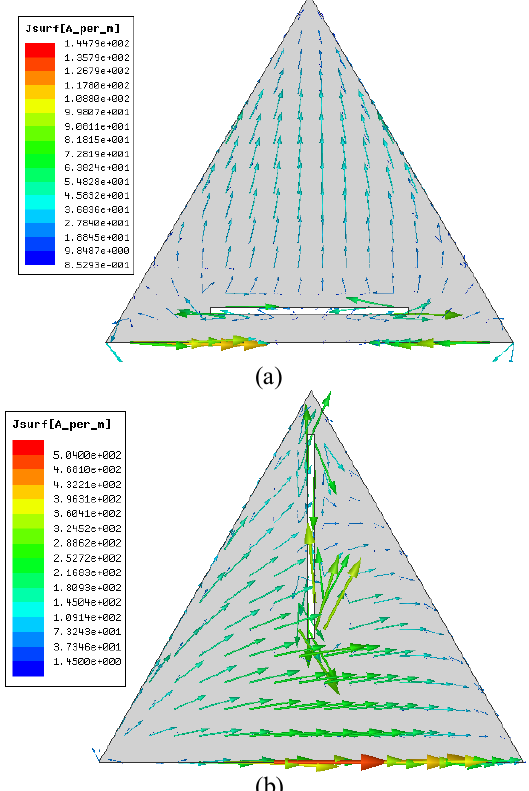
Figure 3: Surface current distribution of triangular patch after adding slots (a) horizontal slot (b) vertical slot.